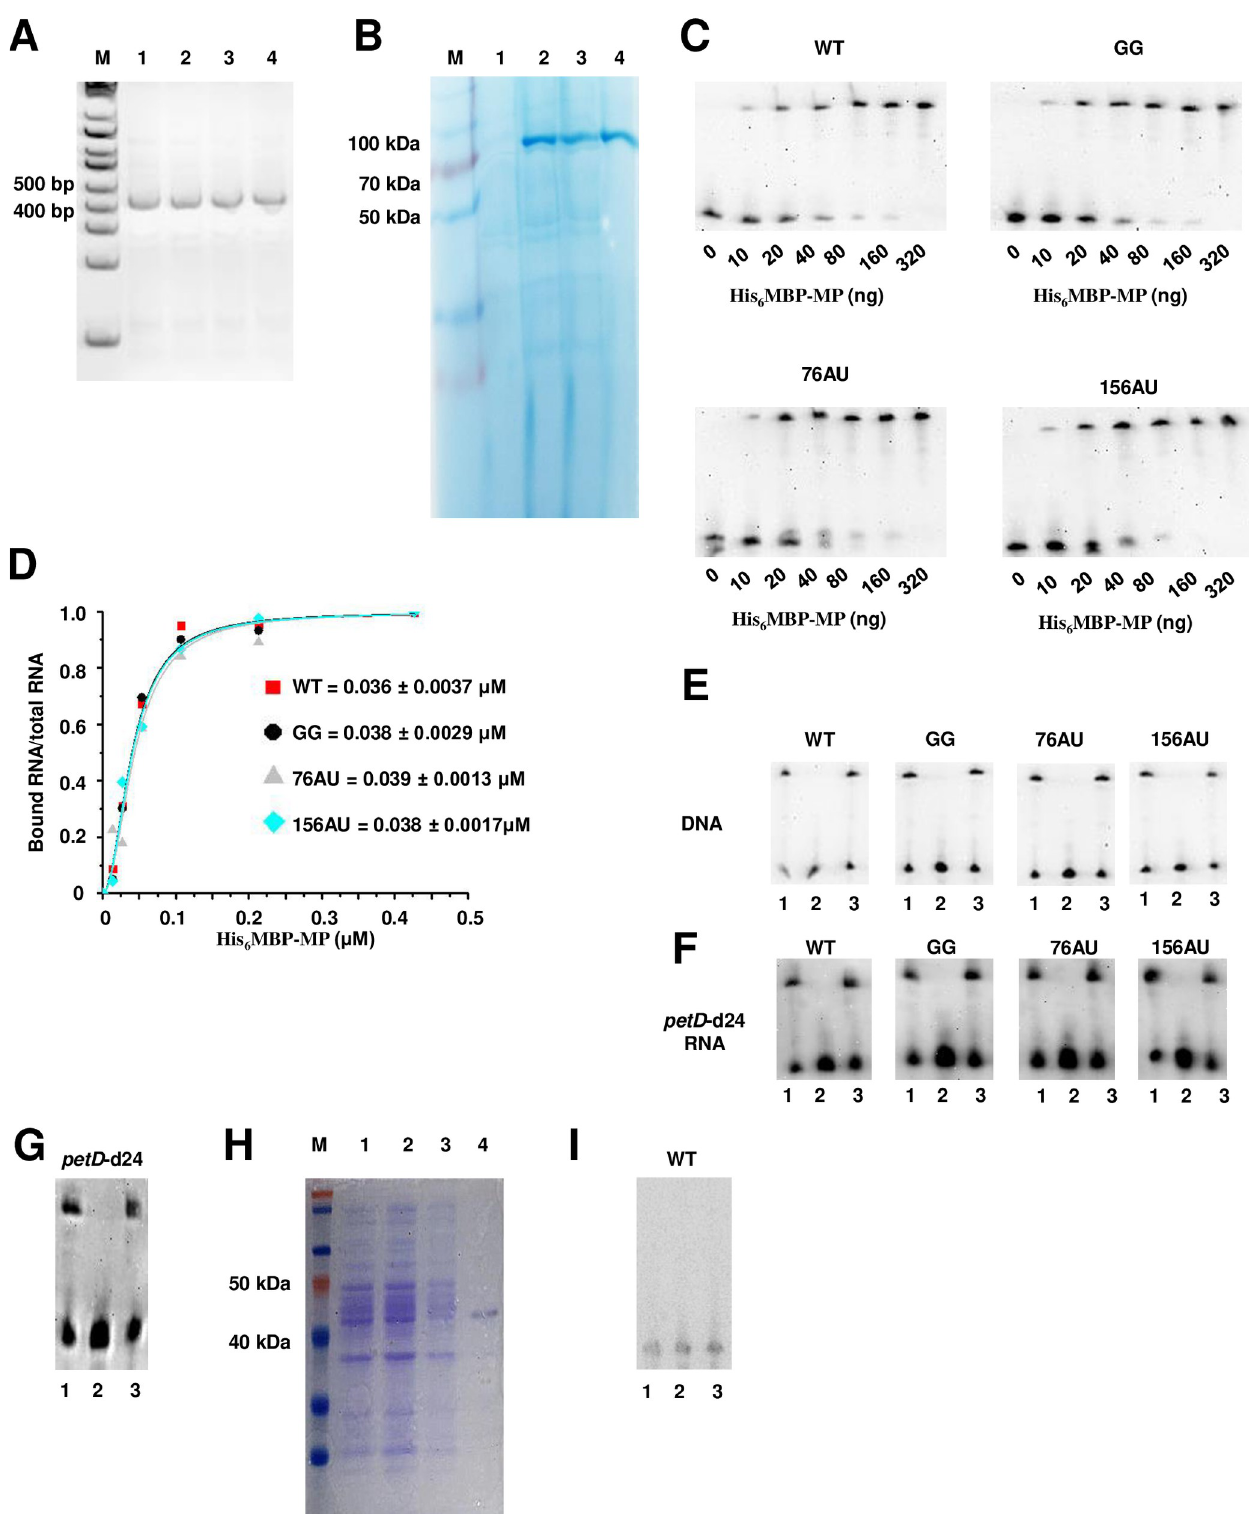
Fig 5. TMV MP binds WT PSTVd and GG, 76AU, and 156AU mutants. (A) Folded full-length PSTVd in vitro transcripts prepared for EMSA. After folding, PSTVd WT and mutant RNAs were tested for homogeneity by electrophoresis through 6% native polyacrylamide gel. The image was taken after